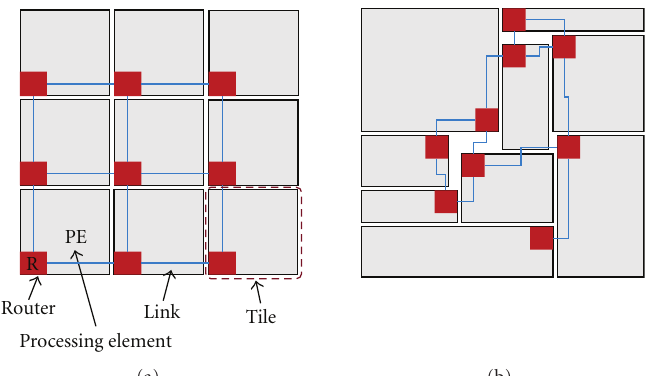
Figure 1: (a) 2D homogeneous NoC design. A tile is composed of a router (R) and a generic processing element (PE). A PE can implement any IP/core of a given application. Routers are interconnected via physical links. (b) Custom heterogeneous NoC design.